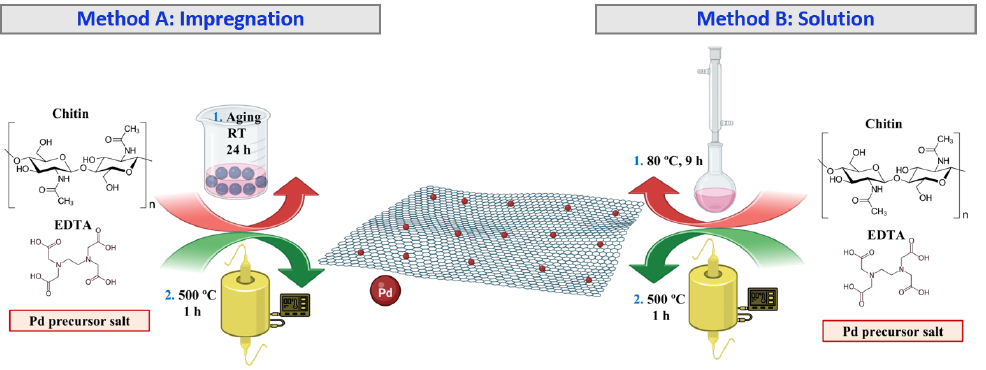
Figure 1. Schematic representation of the synthetic strategies considered for the preparation of Pd-N/C